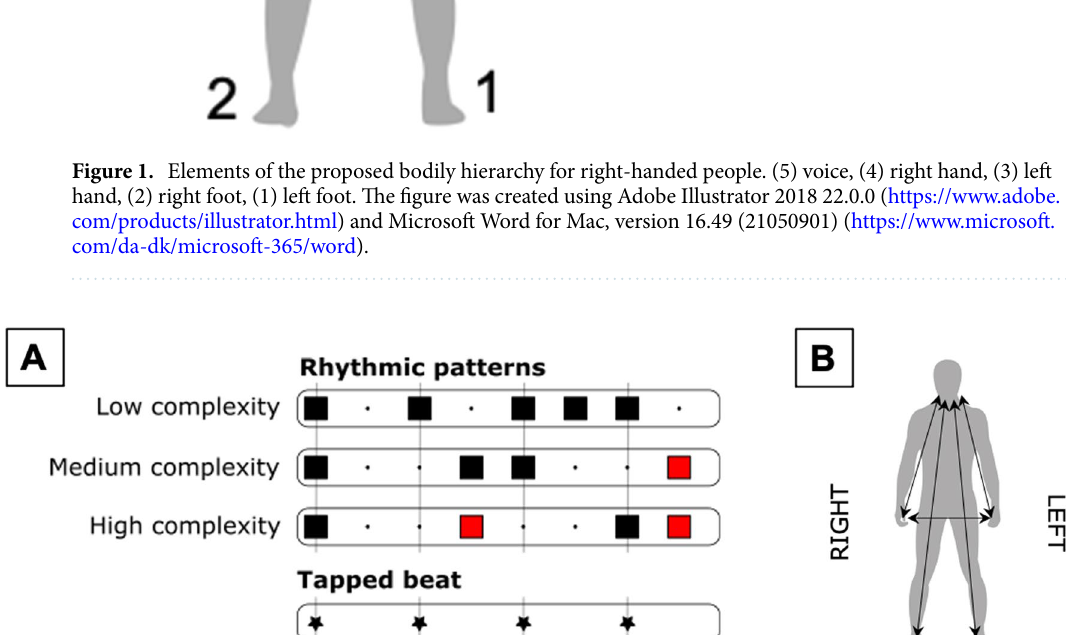
sound by tapping, the participants were instructed to vocalize the syllable ‘da’, when using their voice. Partici- pants used combinations of five different effectors to perform the rhythm/beat tasks: voice (V), right hand (RH), left hand (LH), right foot (RF) and left foot (LF). Henceforth, when referring to a combination pair, a plus sign will be used, i.e., RH + LF. The combinations including the voice were of primary interest, as all combinations of hands and feet had already been studied previously 25 . For the purpose of replication, we also tested RH + LH and RH + LF. Thus, 6 combination pairs were included: V + RH, V + LH, V + RF, V + LF, RH + LH, and RH + LF, each in their dominant and non-dominant version respectively.